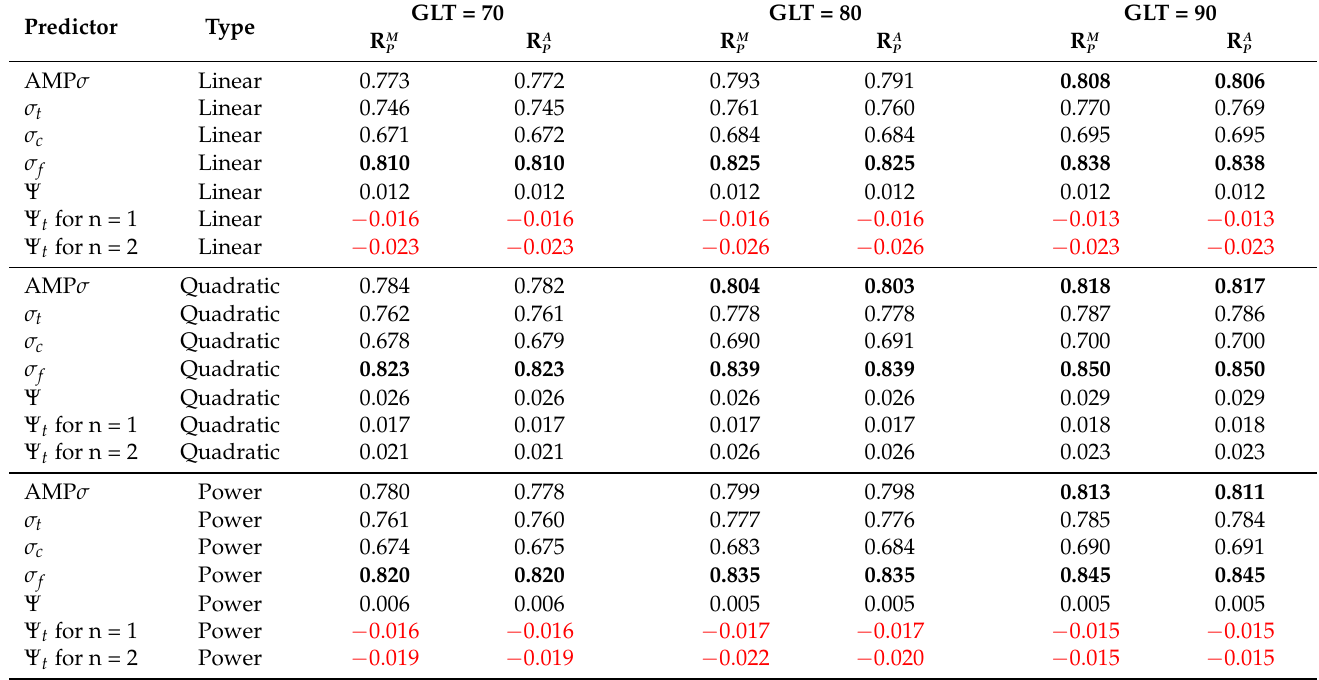
Table 2. Weighted Pearson correlation coefficients obtained with the constitutive model, AnisoH , using C3D4 elements and for different values of GLT: for the maximum variable throughout the cycle, R M , and for the amplitude throughout the cycle, R A . The predictors analysed in this case are: P P the absolute maximum principal stress (AMP σ ), the maximum tensile and compressive stresses ( σ t and σ c , respectively), the fluctuation of stresses ( σ f ) and the mechanical stimulus at the continuum level ( Ψ ) and at the tissue level ( Ψ t ) for two values of n . Values higher than 0.8 are highlighted in boldface; negative values are in red.